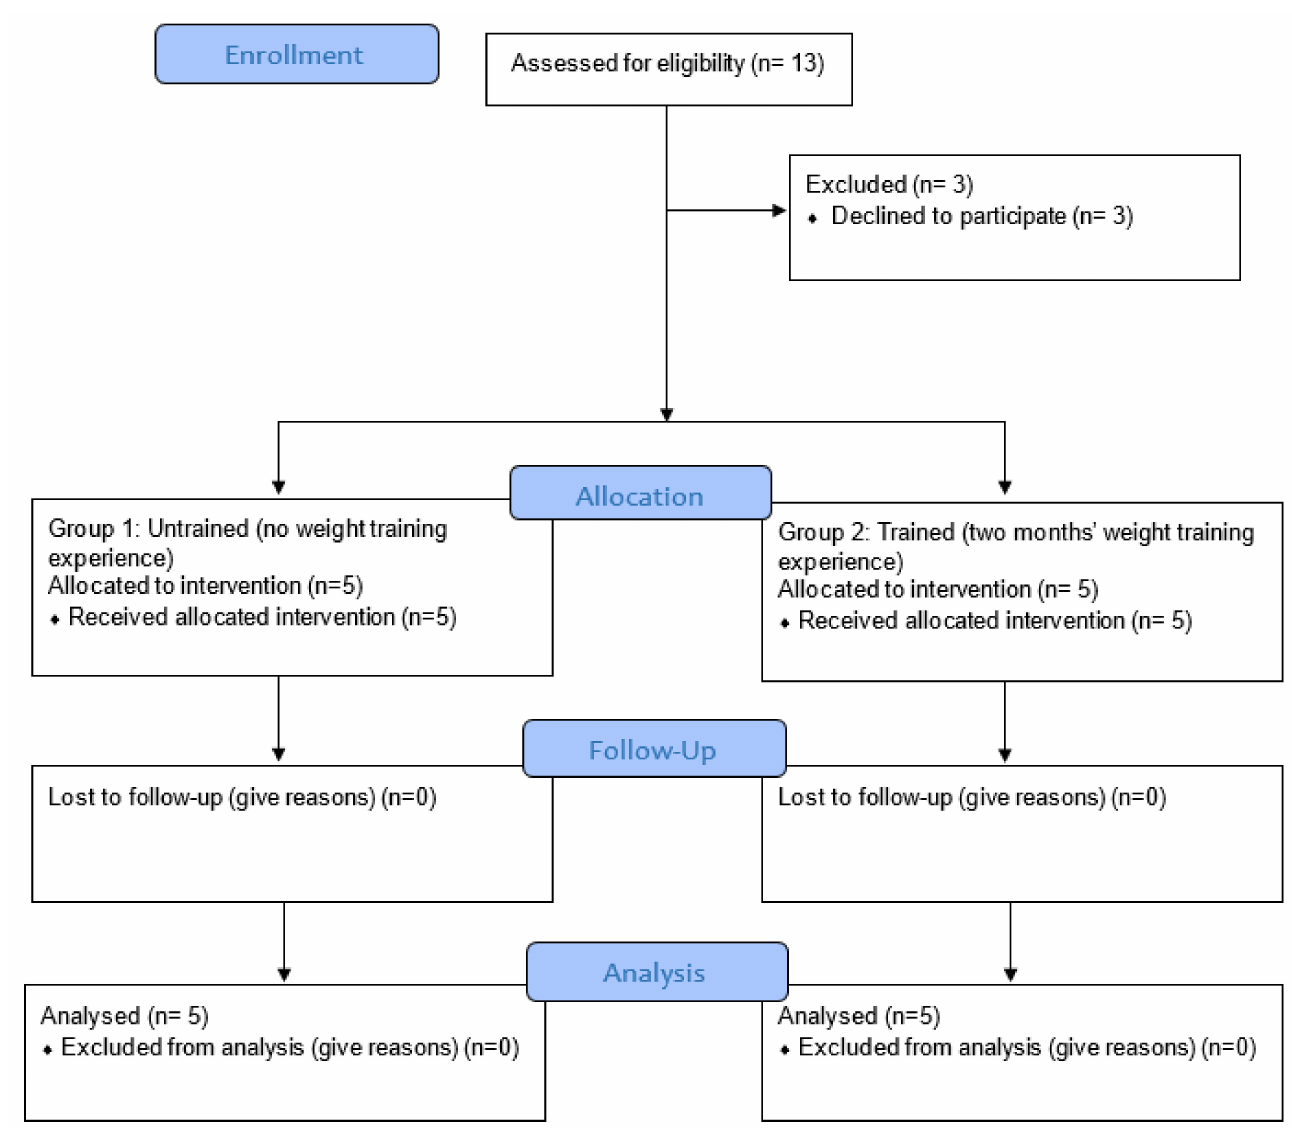
Figure 1. Study Flow